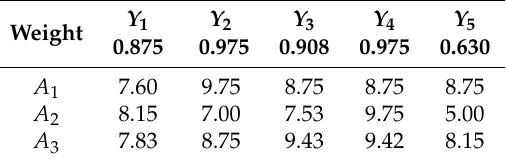
Table 6. Defuzzified decision matrix.